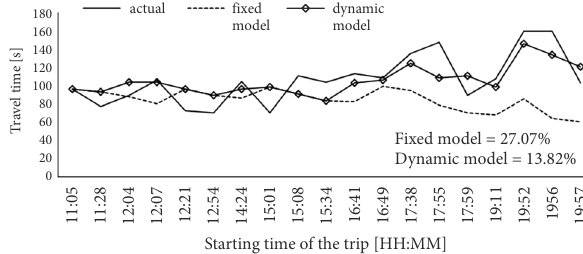
Figure 10. Performance evaluation of a sample subsection (54) on a rainy day